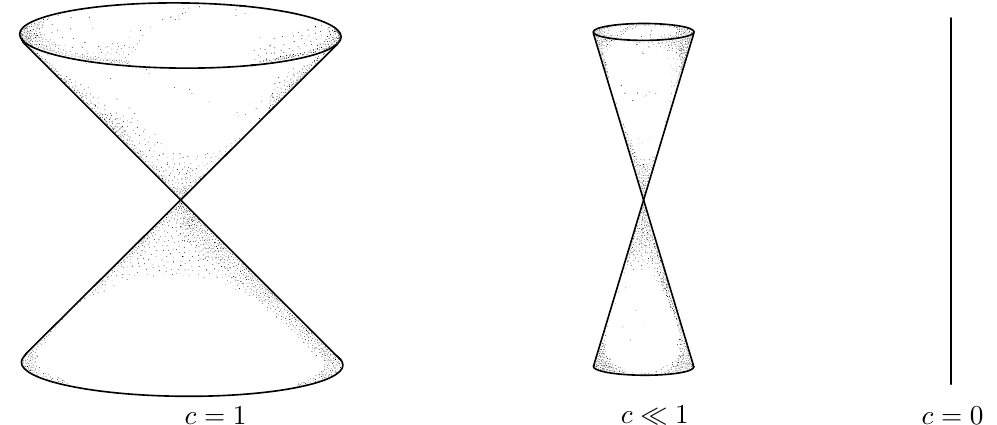
Figure 1 . In the Carroll limit, the lightcones close up. In the second scenario, where c (cid:28) 1 , the dynamics can be described by an expansion of General Relativity around c = 0 [11]. When the lightcone closes completely, all motion ceases to exist (although the limiting behaviour of tachyons allows for motion [12]), and the spacetime becomes